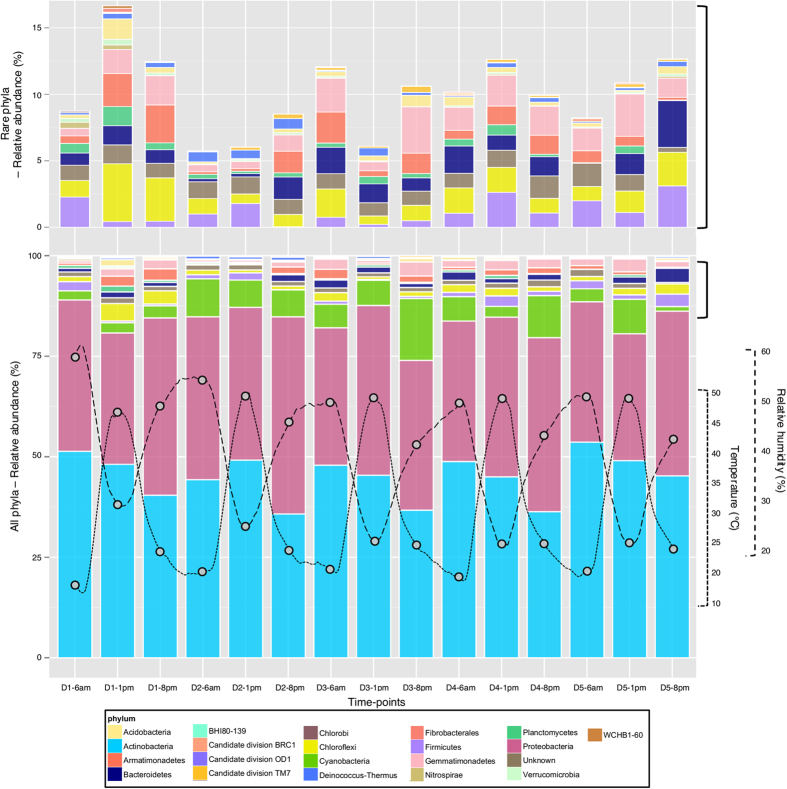
Color-coded bar plot showing the average bacterial phylum distribution in Namib Desert soil over five diel cycles.These patterns are overlayed with climatic data to give an adequate representation of temporal fluctuations within the bacterial groups present.